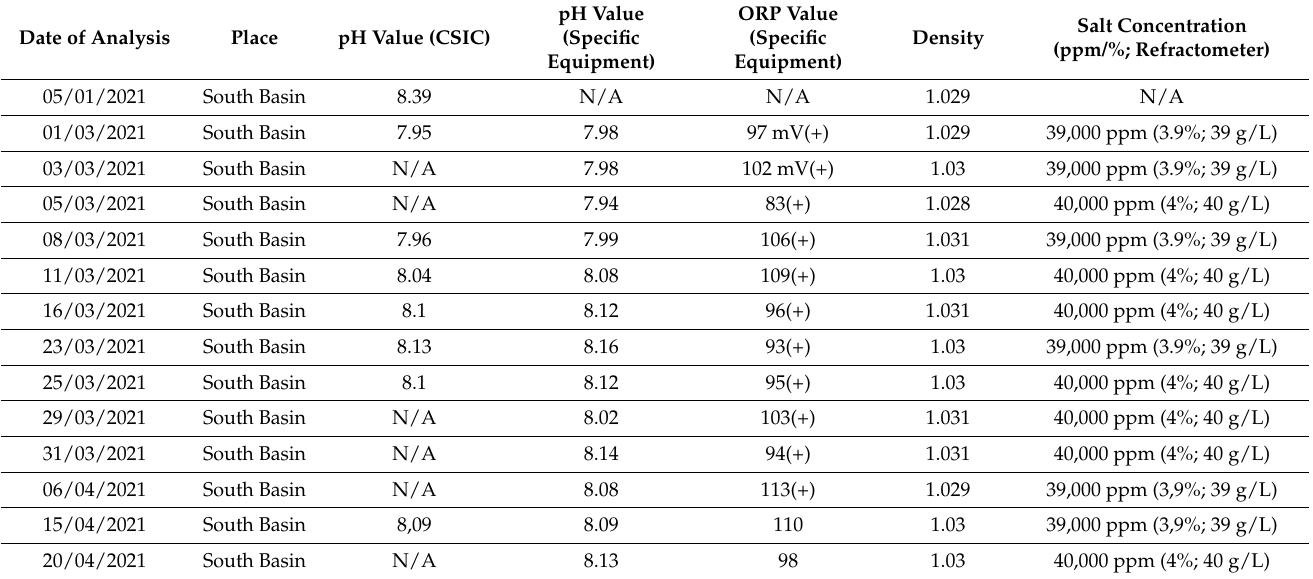
2021 to 20 April